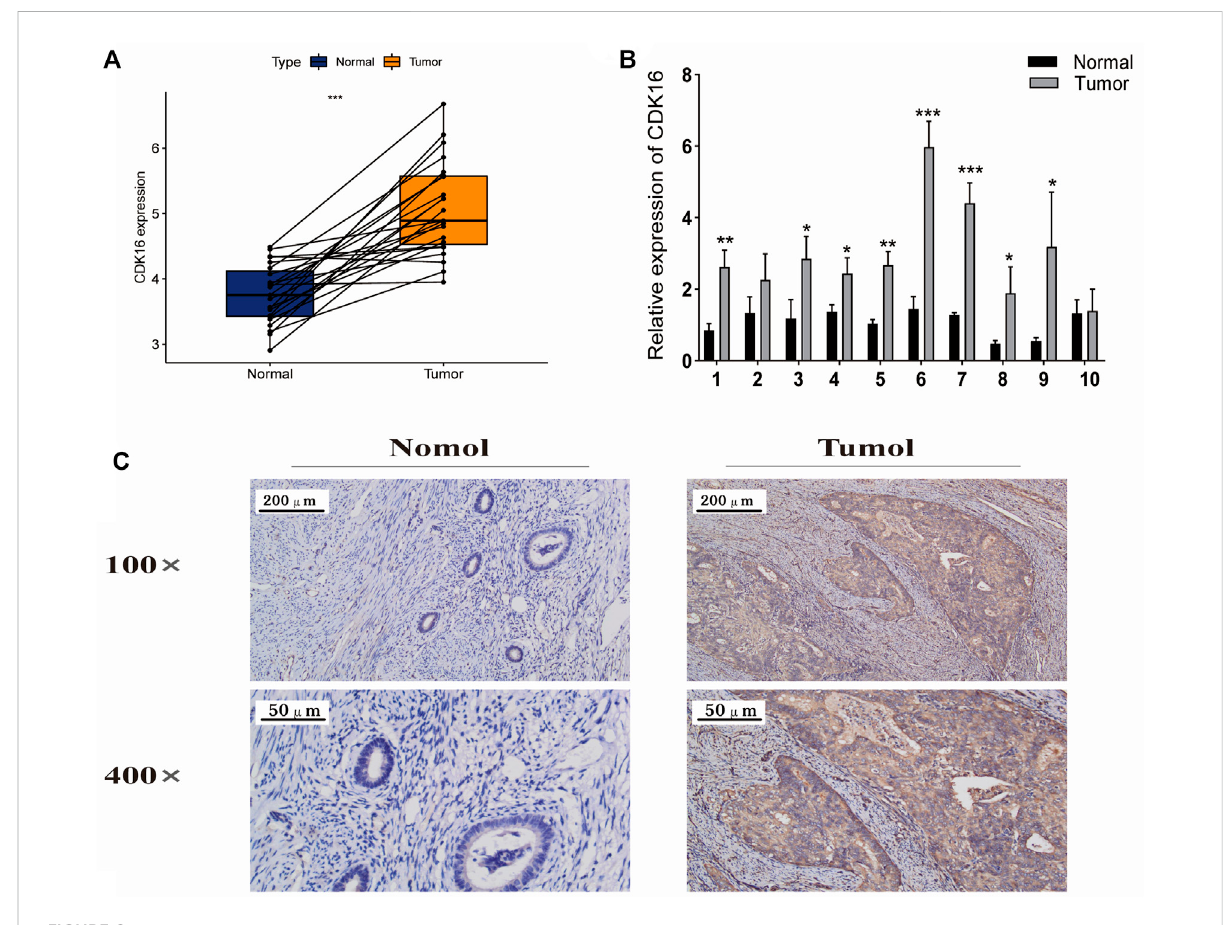
FIGURE 8 Expression of CDK16 in EC and adjacent normal tissues. (A) CDK16 expression was higher in tumour tissues than in adjacent normal tissues in TCGA cohort ( p < 0.001). (B) qRT-PCR revealed that CDK16 expression was higher in tumour tissues than in adjacent normal tissues. (C) Immunohistochemical analysis revealed that CDK16 expression washigher in tumour than in adjacent normal tissues (*, p < 0.005; ** p < 0.01; *** p <